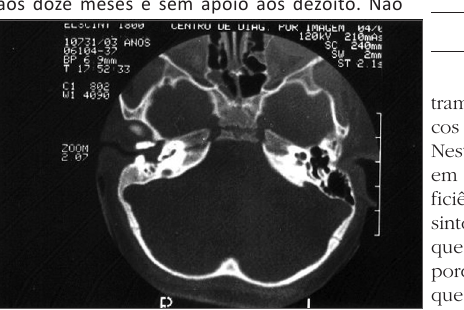
Figura 1. Tomografia computadorizada de ossos temporais corte axial: atresia dos condutos auditivos externos que se afunilam, não chegando até o que seriam as membranas timpânicas. Perda da aeração das células e antro da mastoide e caixa